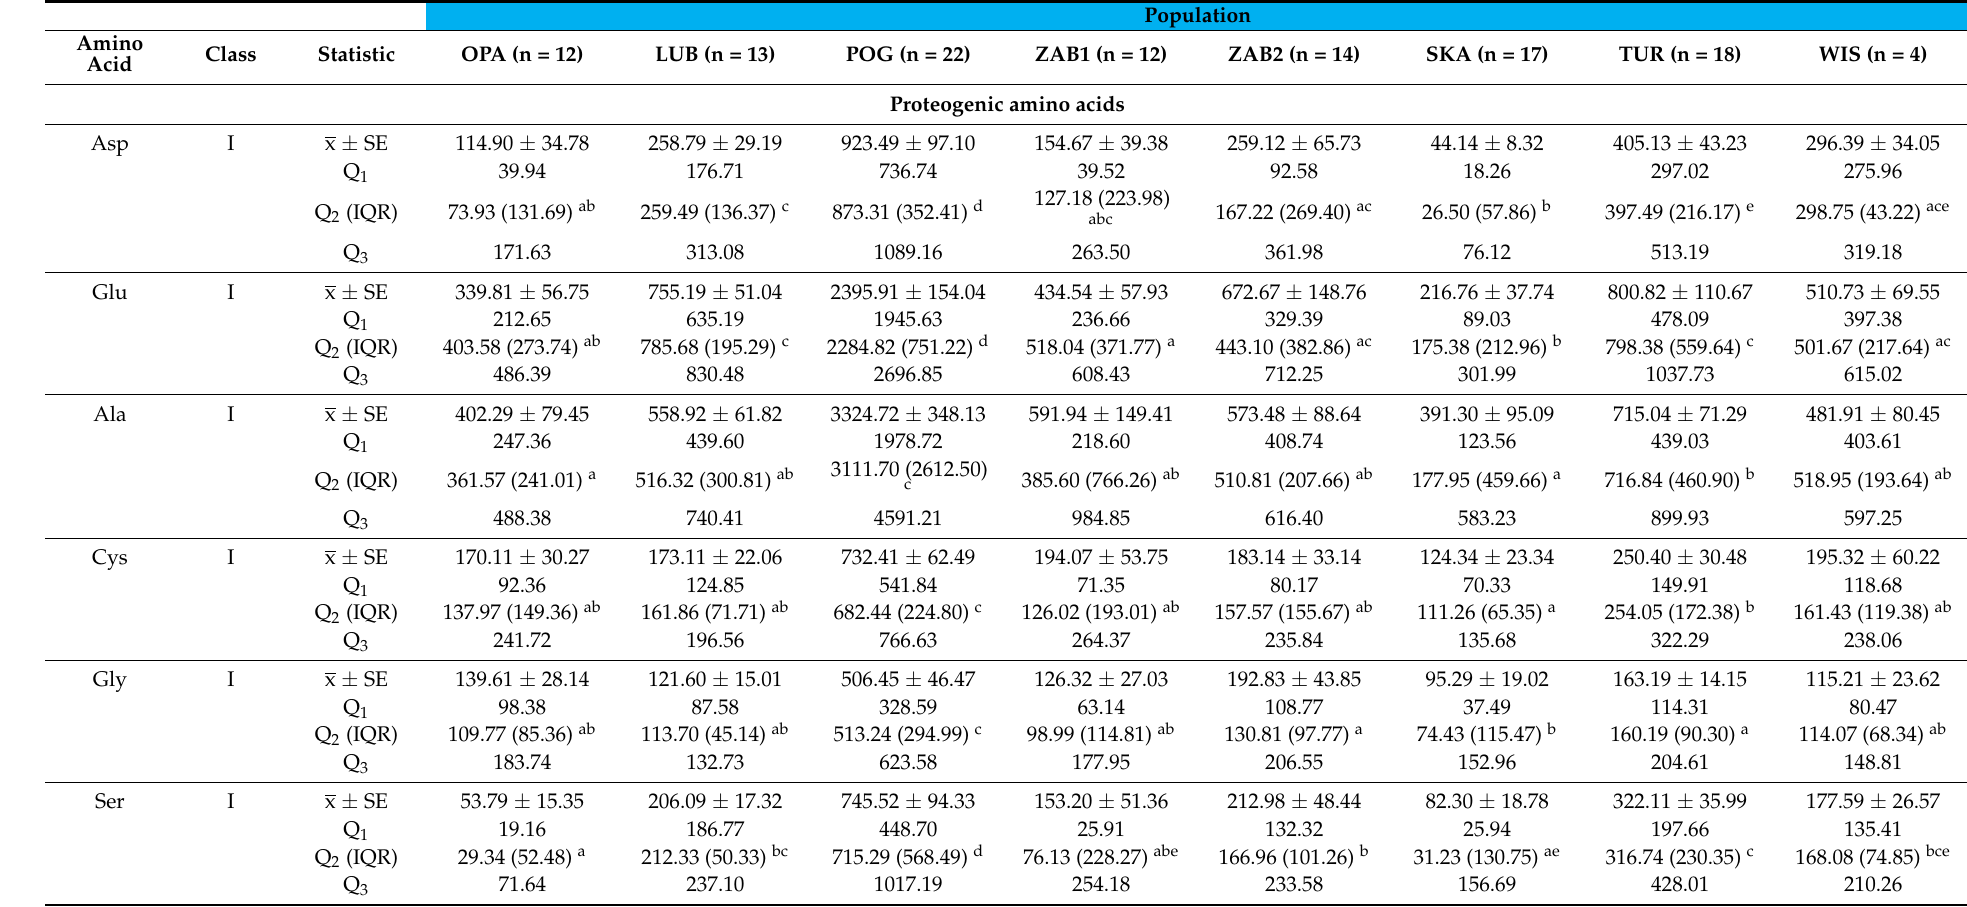
Table 5. The concentration of amino acids ( µ M) in Neottia ovata nectar. Data represent the mean (x) ± standard error (SE), lower quartile (Q1), median (Q2), upper quartile (Q3), interquartile range (IQR). The same letters indicate statistically nonsignificant differences according to the pairwise Wilcoxon Rank Sum test with Benjamini-Hochberg adjustment ( p ≥ 0.05). The number of classes represents the effect of amino acids on insect chemoreceptors: I—no effect; II—inhibition of chemoreceptors; III—stimulate the salt cell; IV—the ability to stimulate the sugar cell